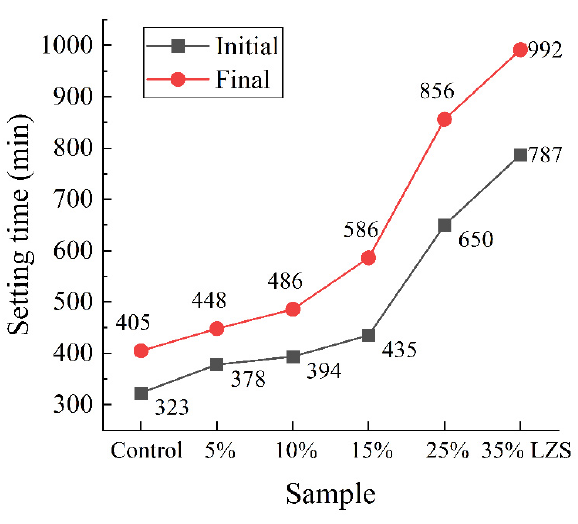
Figure 2. Effect of LZS on the setting time of the mortar [89]. Table 2. Specific gravity and water absorption of the four metallurgical